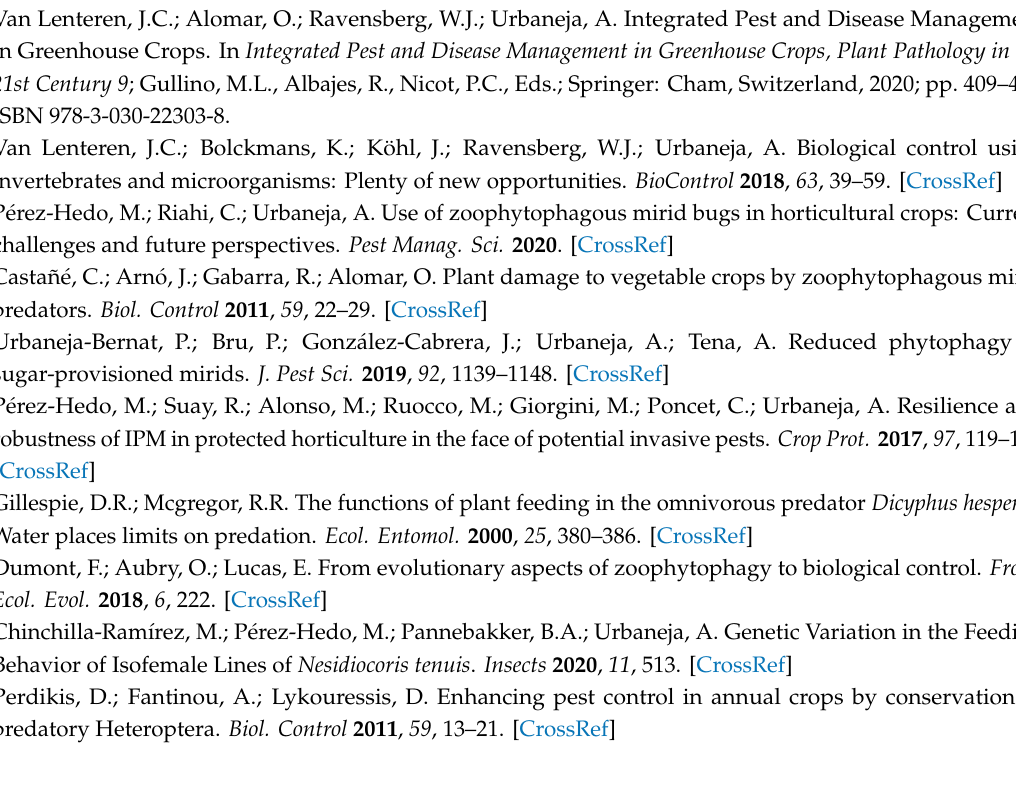
Figure S2: The daily high, average and low relative humidity (RH) recorded over the course of the 4 experiments, Figure S3: Mean ( ± SE) height (cm) and number of flowers found on tomato plants in two five week field cage studies with three di ff erent mirid predators. Experiment 1 (A and C) compared plant growth in cages with clean plants (No Insects), whiteflies and no predators ( B. tabaci ), predator Macrolophus praeclarus + whitefly prey ( M. praeclarus + B. tabaci ) and predator Engyatus modestus and whitefly prey ( E. modestus + B. tabaci ). Experiment 2 (B and D) compared plant growth in cages with clean plants (No Insects), whitefly and no predators ( B. tabaci ), predator Macrolophus praeclarus and whitefly prey ( M. praeclarus + B. tabaci ) and predator Nesidiocoris tenuis and whitefly prey ( N. tenuis + B. tabaci ), Figure S4: Mean ( ± SE) height (cm) of tomato plants in five week field cage studies with clean plants (No Insects), whiteflies and no predators ( B. tabaci ), on whitefly infested tomato plants with Macrolophus praeclarus in cages with only tomato plants ( M. praeclarus + B. tabaci + Tomato) or five tomato plants with one sesame plant added ( M. praeclarus + B. tabaci + Tomato + Sesame) and on prey infested tomato plants with Nesidiocoris tenuis in cages with only tomato plants ( N. tenuis + B. tabaci + Tomato) or five tomato plants with one sesame plant added ( N. tenuis + B. tabaci + Tomato + Sesame), Data File S1: Supporting Field Cage Study Data (available upon request during review process and upon acceptance of